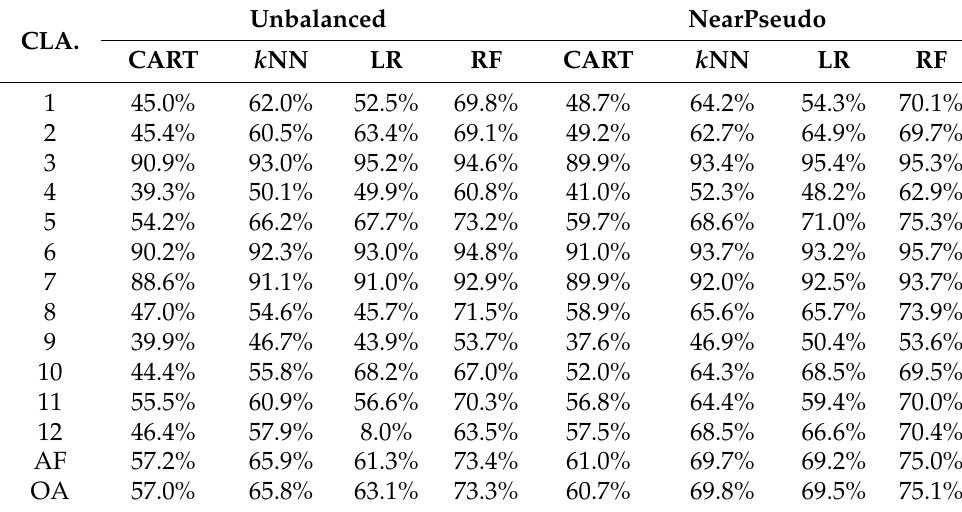
Table 5. Classification accuracy (%) of different